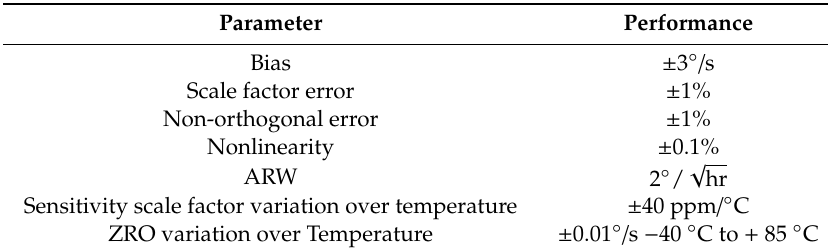
Table 3. ADI-16367 Characteristic.